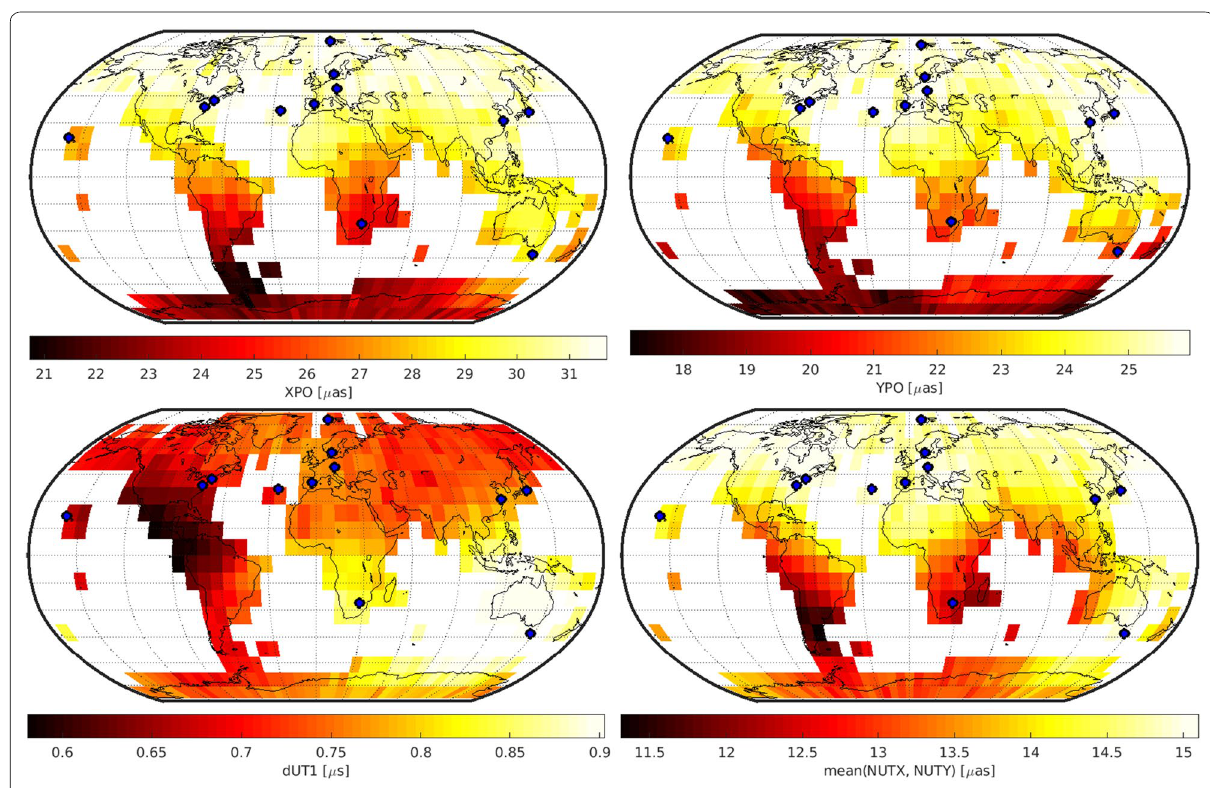
Fig. 4 Precision of geodetic parameters for the 12